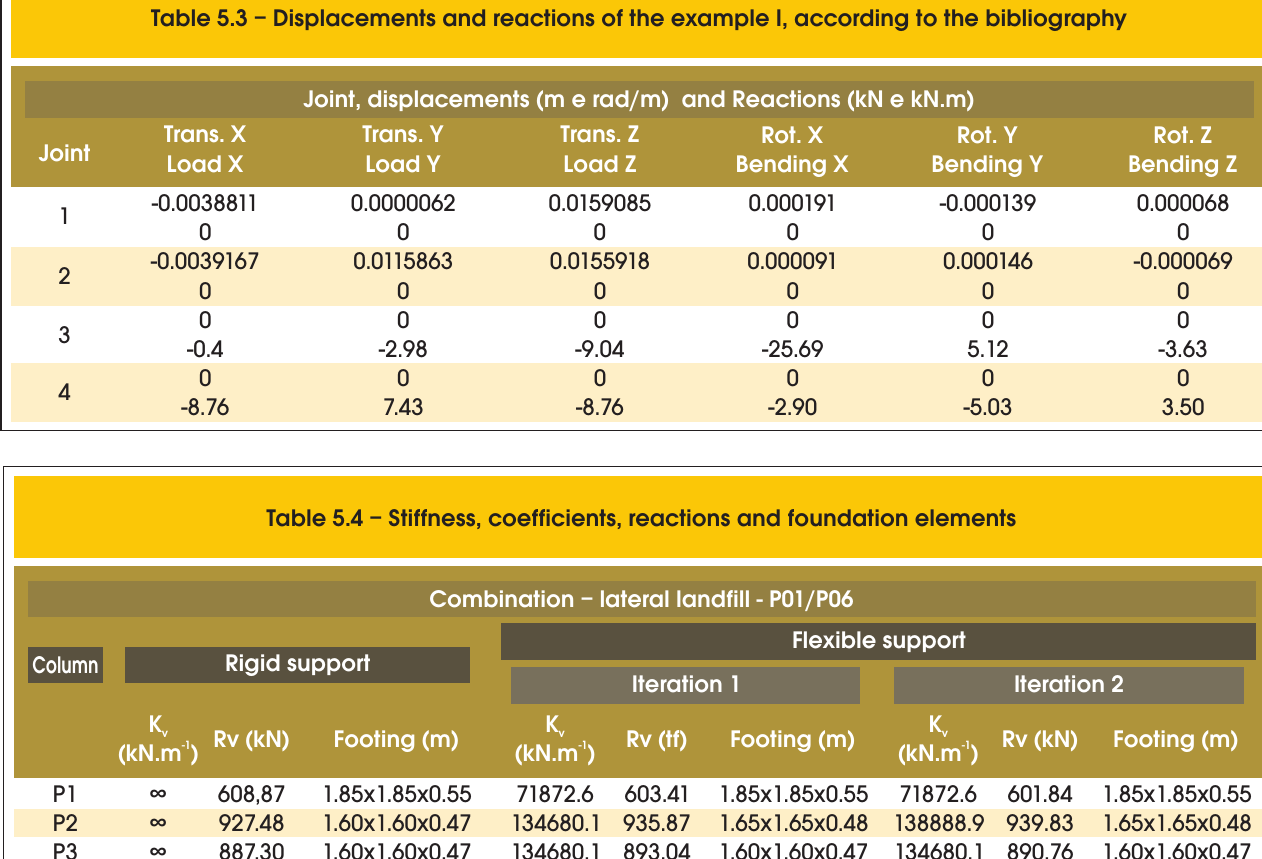
Table 5.3 – Displacements and reactions of the example I, according to the bibliography